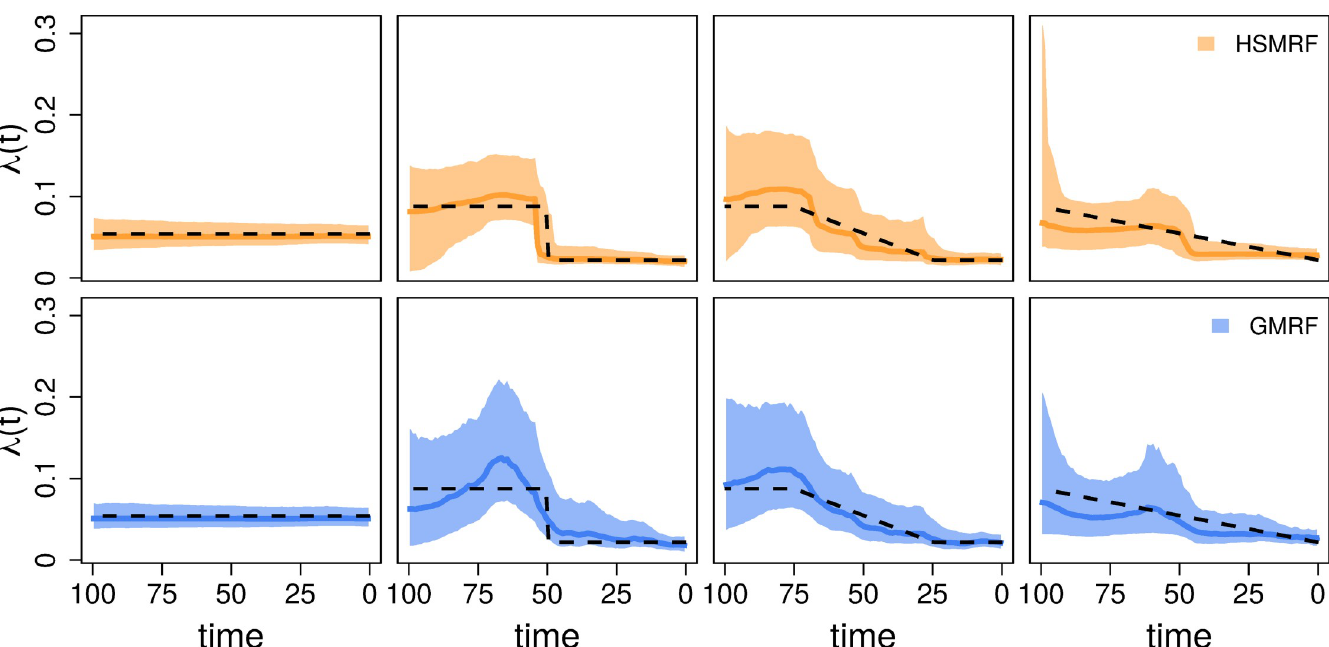
Fig 2. Inferred birth-rate trajectories from four individual simulations. The dashed line is the true simulating birth rate, the dark colored line is the posterior median trajectory (the median is taken separately for each grid cell), and the shaded region shows the 90% Credible Interval (CI) for the rate. The leftmost column is from the constant-rate simulations, and the right three columns demonstrate the effect of changing the shift duration (the length of the tree over which the birth rate changes), from an instantaneous shift to a constant change model. When we focus instead on the location of the shift, all simulations are piecewise-constant as in the second column. In each column, we show the simulation with the most average performance measured in terms of the Mean Absolute Deviation of both the GMRF and HSMRF.